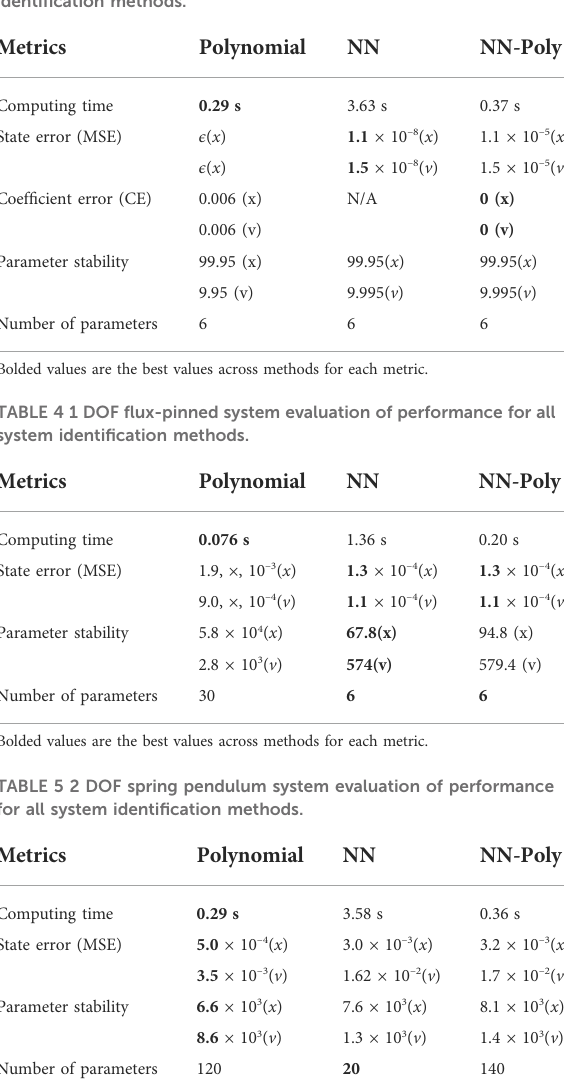
Bolded values are the best values across methods for each